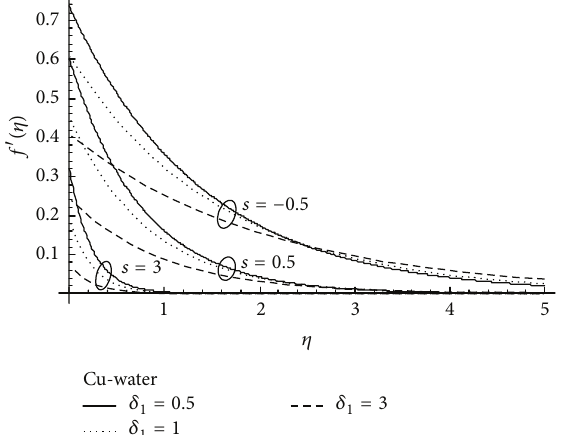
Figure 6: Effect of the first slip 𝛿 1 on velocity distribution 𝑓 󸀠 (𝜂) at different values of 𝑠 for Cu-water nanoparticles when 𝑃𝑟 = 6.2 , 𝜙 = = 0 . 0.1 , and 𝛿 2